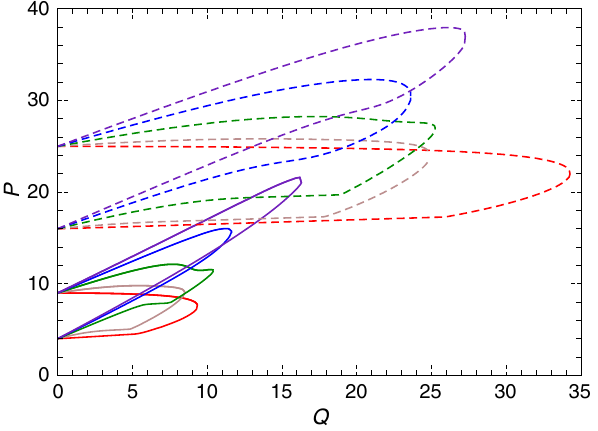
FIG. 10. Higher real eigennumbers of Eq. (34) at different α .